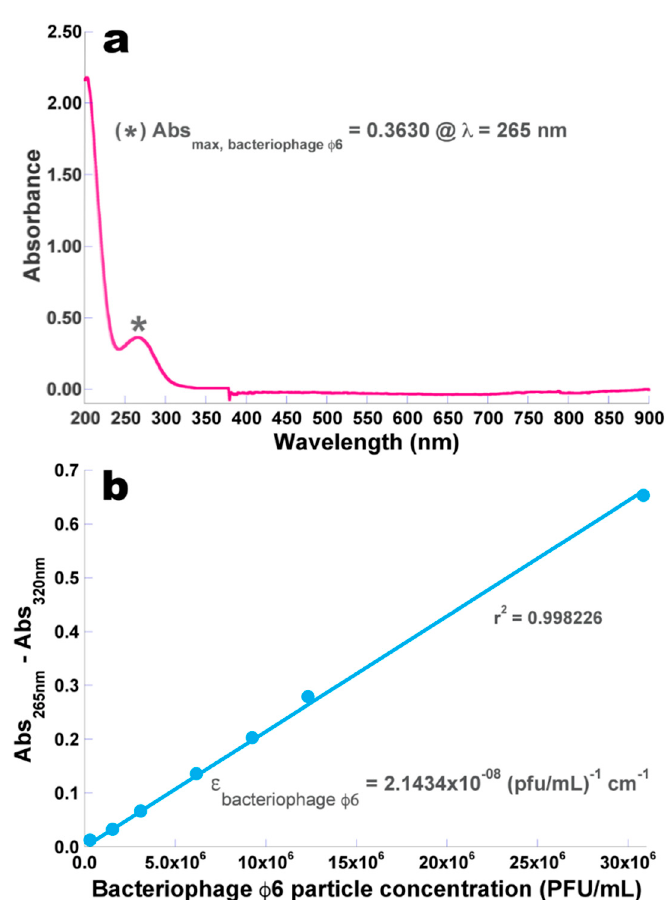
Figure 3. Wavelength screening of phage φ 6 suspension allowing observation of the wavelength producing maximum absorption of phage φ 6 particles ( a ) and the calibration curve produced for the relationship between the concentration of (whole) phage particles in suspension and the absorption of the suspension at 265 nm corrected for cell debris and other intracytoplasmic proteins at a wavelength of 320 nm ( b